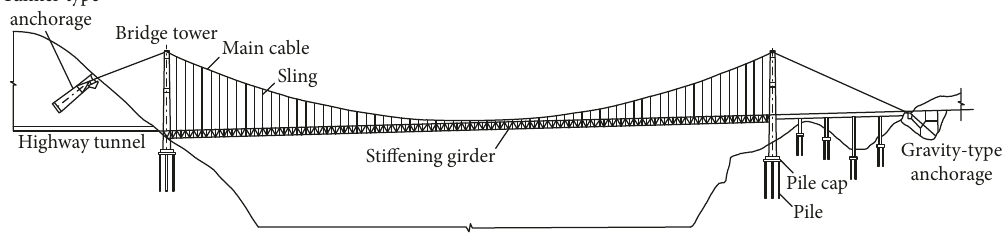
Figure 1: Structural diagram of suspension